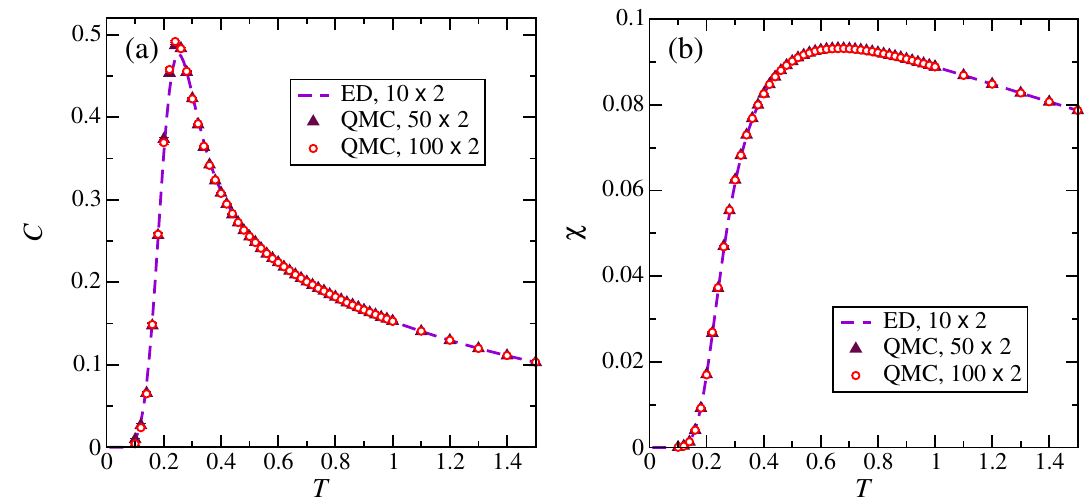
Figure 7: Magnetic specific heat, C , and susceptibility, χ , shown per spin for a partially frustrated ladder with rung coupling J ⊥ = 1.4, leg coupling J (cid:107) = 1, and diagonal coupling J × = 0.9. We compare QMC results obtained for ladders of L = 50 and 100 rungs with ED results for L =